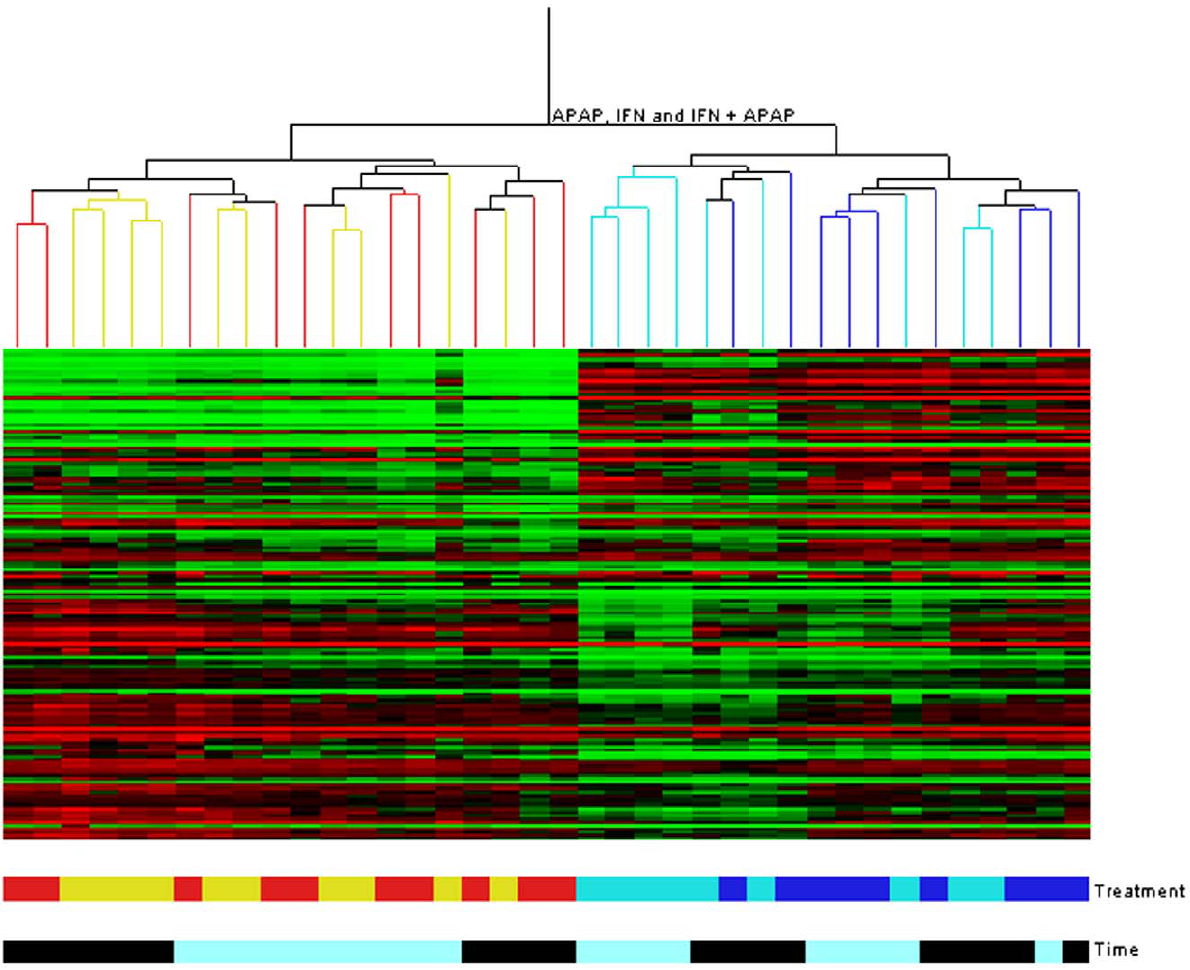
Figure 1. Correlation/cluster analysis of significantly altered probes. Samples clustered into two branches with vehicle and APAP treated mice on the left, and IFN- b and combined treatment on the right. Each column represents a single sample. Colours indicate high relative signal intensity (red), low relative signal intensity (green), and similar signal intensity (black) in the reference and sample channels. The branches of the tree are coloured by treatment.